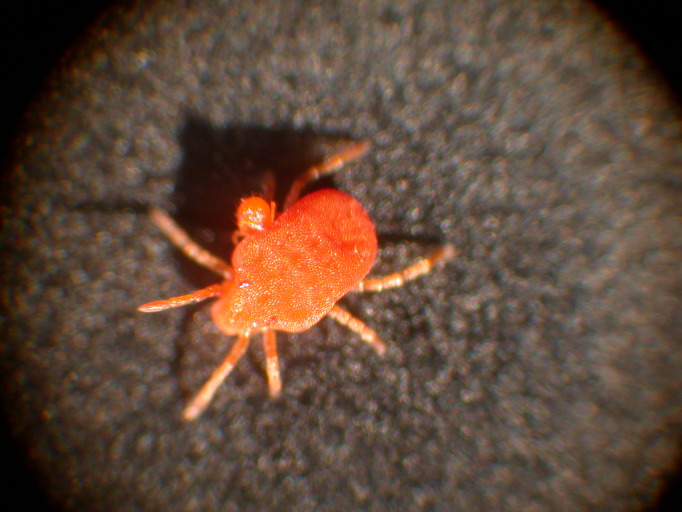
Calyptostoma sp. parasitised by larva of Johnstoniana sp. Photo Joanna Mąkol.